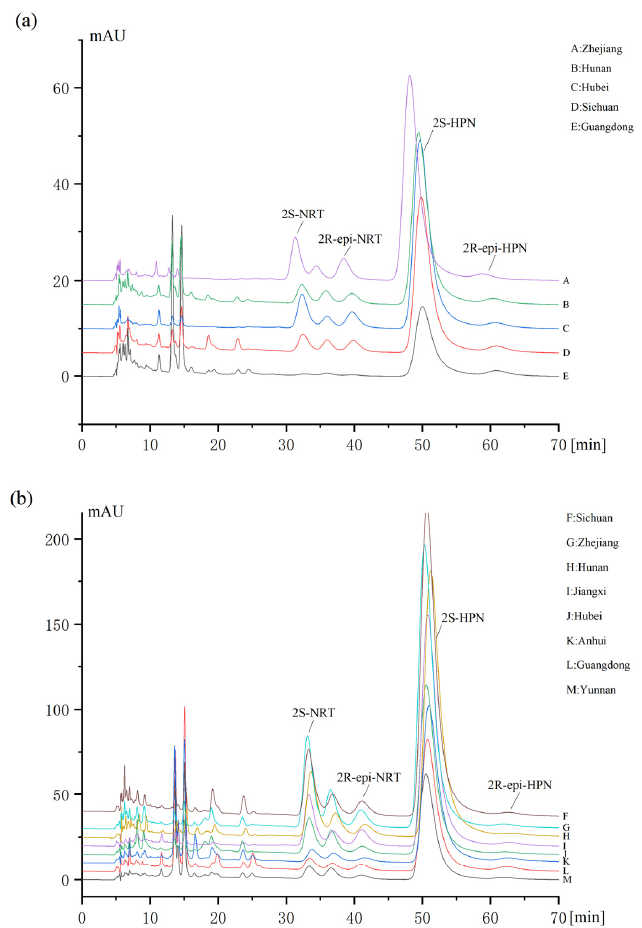
Figure 3. Detection of 2 S - and 2 R -epimers of hesperidin and narirutin in Chenpi ( a ) and Qingpi ( b ) herbs of different origins. HPN: hesperidin; NRT: narirutin.